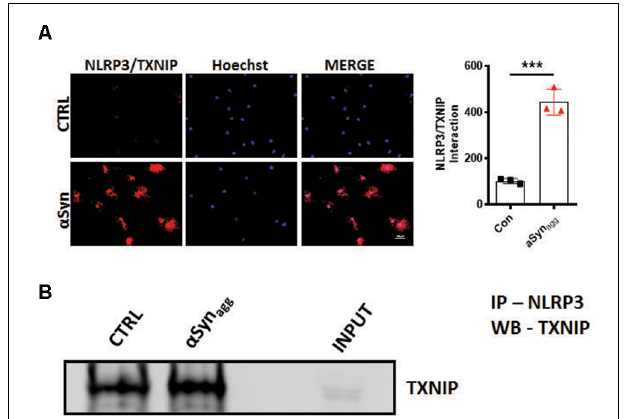
FIGURE 3 | α Syn agg promotes TXNIP interaction with NLRP3 in mouse primary microglia. (A) Representative immunofluorescence images of in situ proximity ligation assay (PLA) displaying interaction between TXNIP and NLRP3 in mouse primary microglia stimulated with α Syn agg for 24 h. Quantification of PLA puncta reveals the maximal amount of PLA puncta in α Syn agg stimulated mouse PMG. TXNIP-NLRP3 proximity ligation signal (red), and DAPI (blue). (B) Co-IP and WB analysis demonstrating the interactions between TXNIP and NLRP3 in α Syn agg stimulated primary microglia. Quantification of TXNIP-NLRP3 interactions using densitometric scanning analysis. Cell lysates were prepared from mouse primary microglia stimulated with or without α Syn agg for 24 h and subsequently immunoprecipitated (IP) with NLRP3 followed by immunoblotting with a TXNIP antibody. Data are shown as mean ± SEM. *** p < 0.001 vs. α Syn or controls using two-tailed t -test; N =